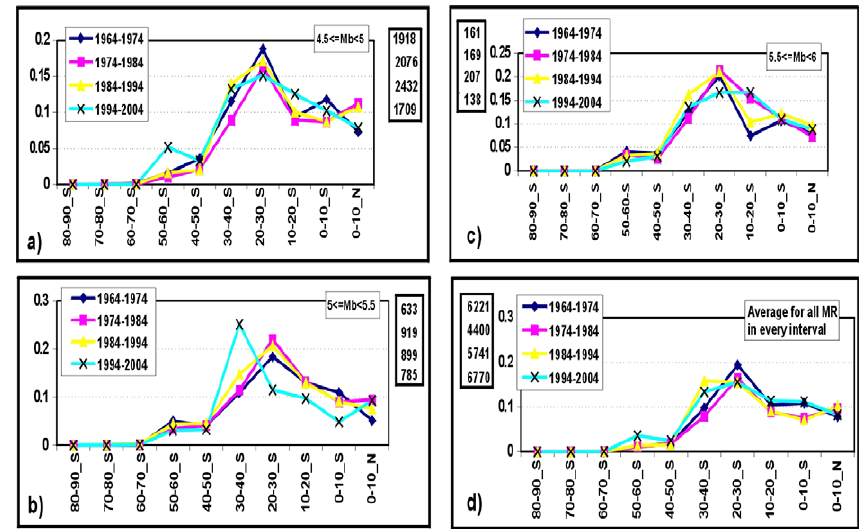
Figure 4. Latitudinal distributions of the earthquakes in the Pacific part of the South America for four 10-year time intervals. The horizontal axes are the latitudinal belts; vertical axes are the binormed numbers of events. (a) , (b) , and (c) are latitudinal distributions of events for three different magnitude ranges; (d) is distribution of the mean value calculated from five magnitude ranges over four 10-year periods. The total numbers of seismic events in the corresponding time period are shown in rectangle in the upper right corner of (a) and (b) and in upper left corner of (c) and (d).